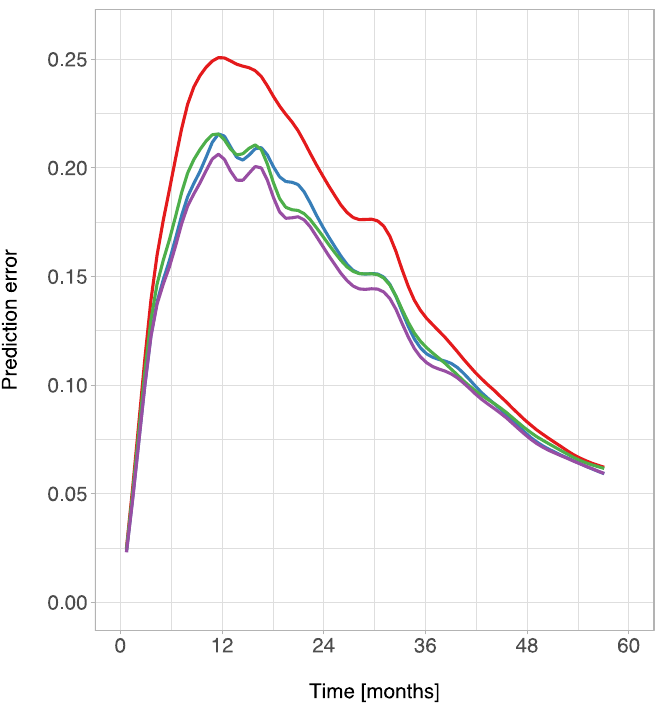
Figure 5. Prediction error curves for Kaplan–Meier estimates based on the ALBI grade (blue), PNI (green), ALBI-PNI grade (purple), and the unstratified sample (red).